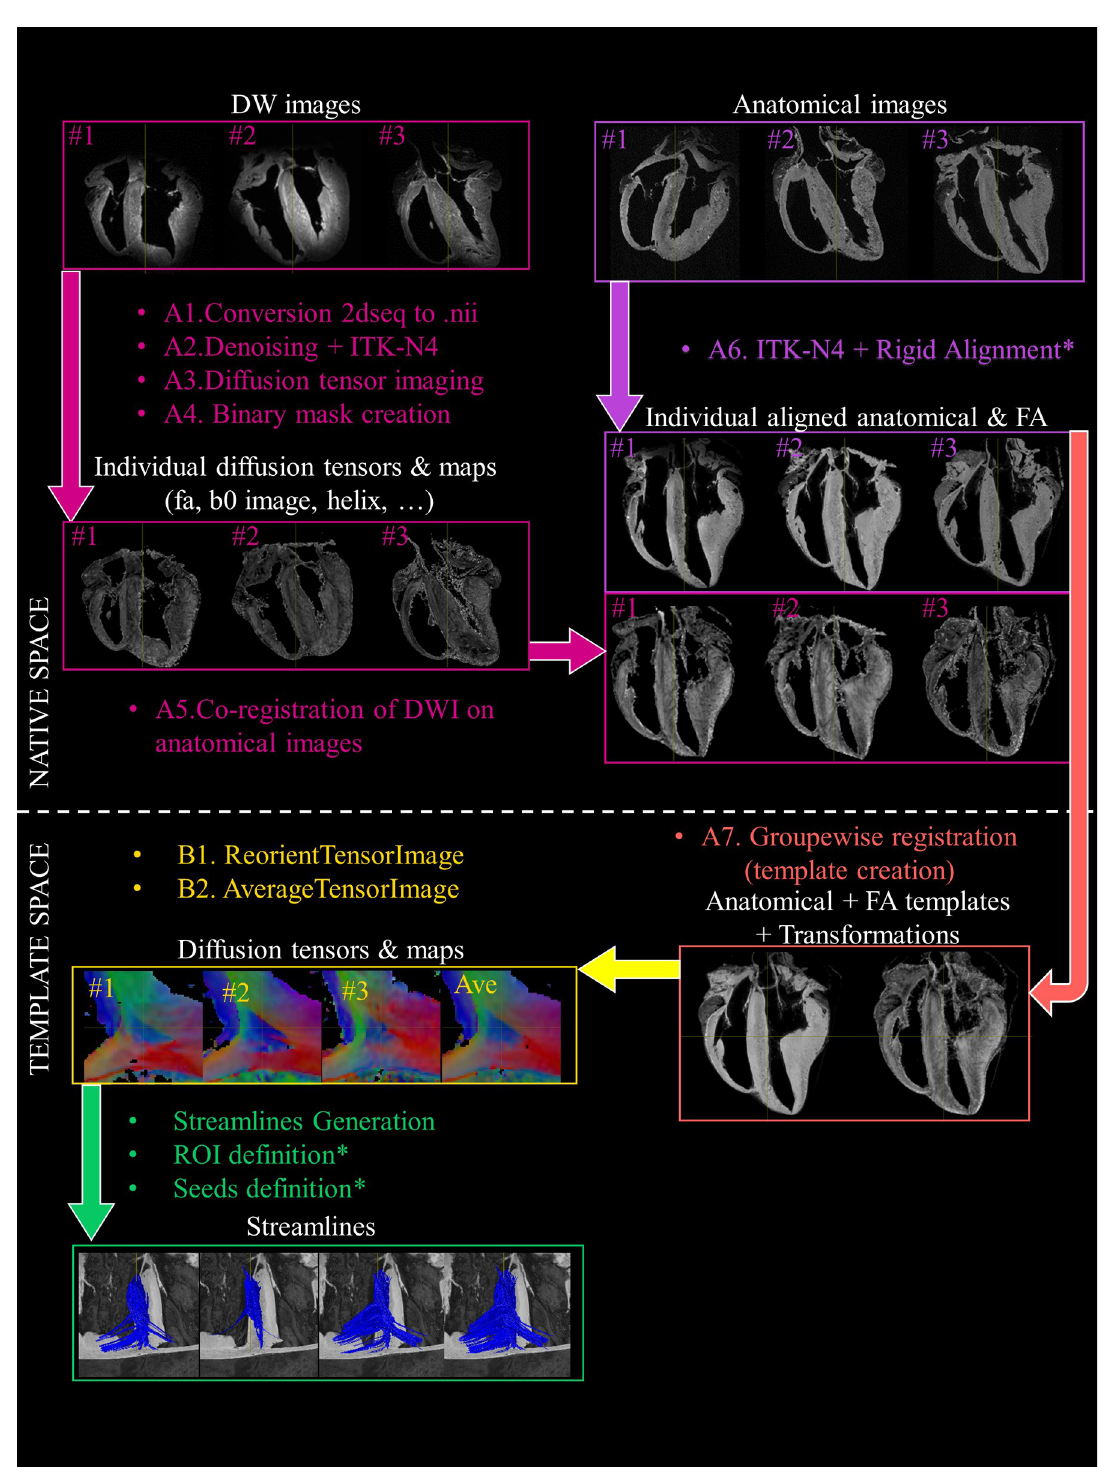
Fig 1. Block diagram of the processing steps. A) Anatomical and DW images were first handled separately with a B1 inhomogeneity field correction. Then, anatomical images were manually aligned along the long axis using ITK-snap while diffusion tensor calculations were performed before any registration. Secondly, DW images were registered to the anatomical images. Model generation was performed using the symmetric normalization transformation (SyN) model using the anatomical and FA images. B) The individual diffusion tensors were then deformed into the template space and an average diffusion tensor was created. After this step, the diffusion